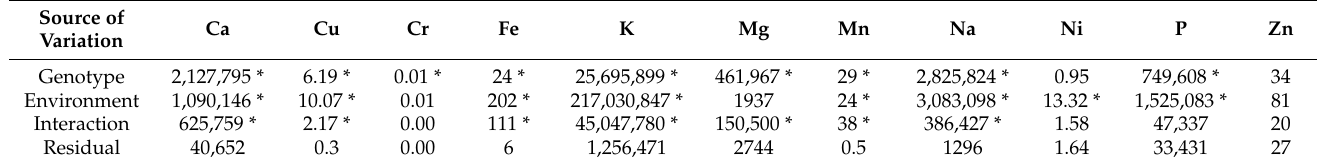
Table 4. Two-way ANOVA of mineral elements (* = p < 0.05).